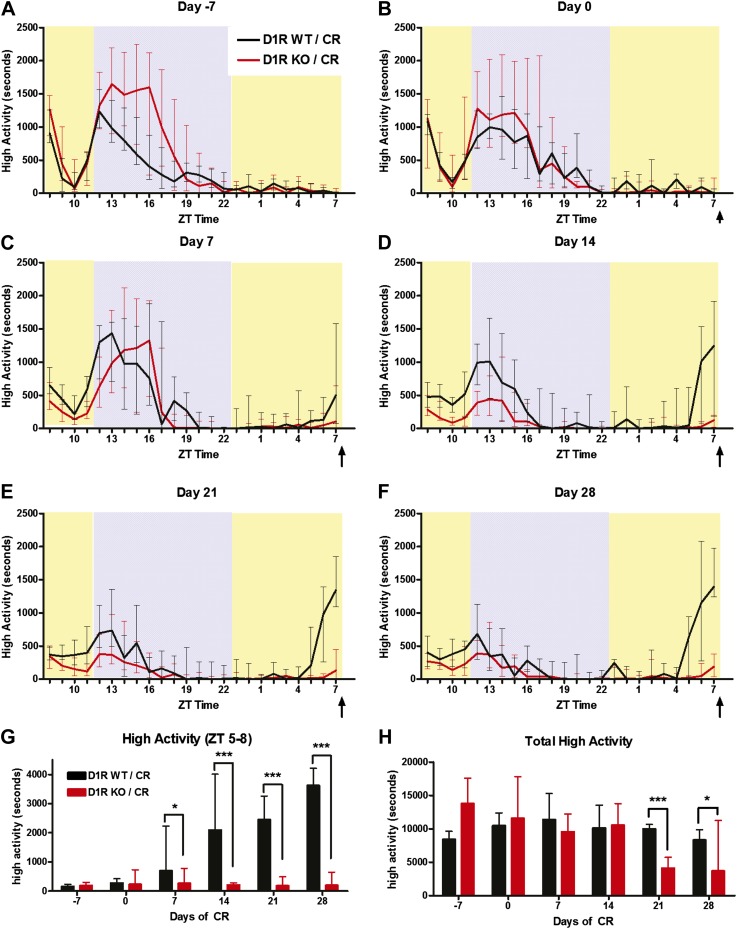
High activity data for D1R knockout mice in seconds (median +/- SEM).High activity behaviors of D1R KO and WT (same mice as Figure 2) in terms of median seconds (unnormalized) for (A) day 7, (B) day 0, (C) day 7, (D)day 14, (E) day 21, and (F) day 28. (G) Amount of high activity in the 3 hr preceding scheduled feeding in seconds. (H) Amount of total high activity over 24 hr recordings in seconds.